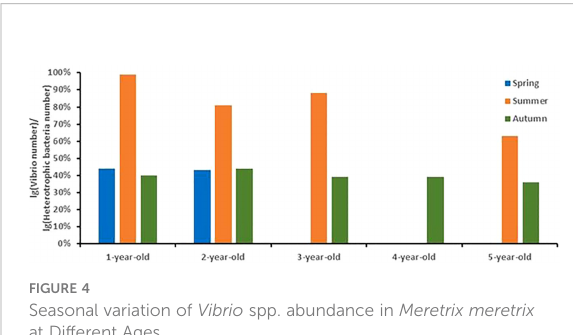
FIGURE 4 Seasonal variation of Vibrio spp. abundance in Meretrix meretrix at Different